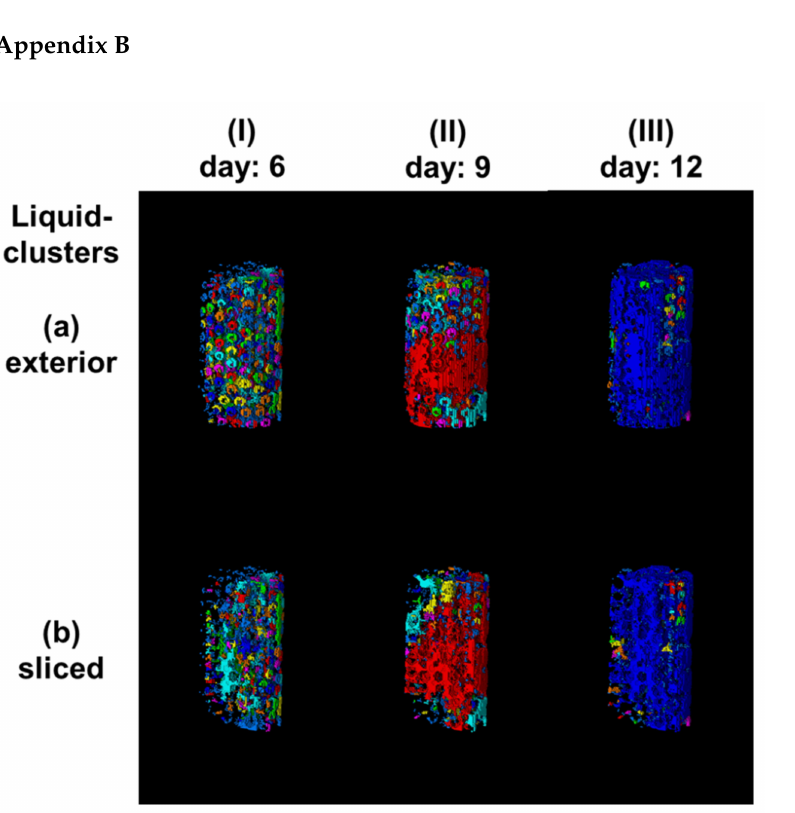
Figure A1. Visualization of liquid clusters. The same dataset is shown from an exterior perspective ( a ) and sliced through the center ( b ). On day 6, ring-like structures of retained water can be recognized. At day 9, a dominant cluster can be recognized; this cluster almost covers the complete liquid phase at day